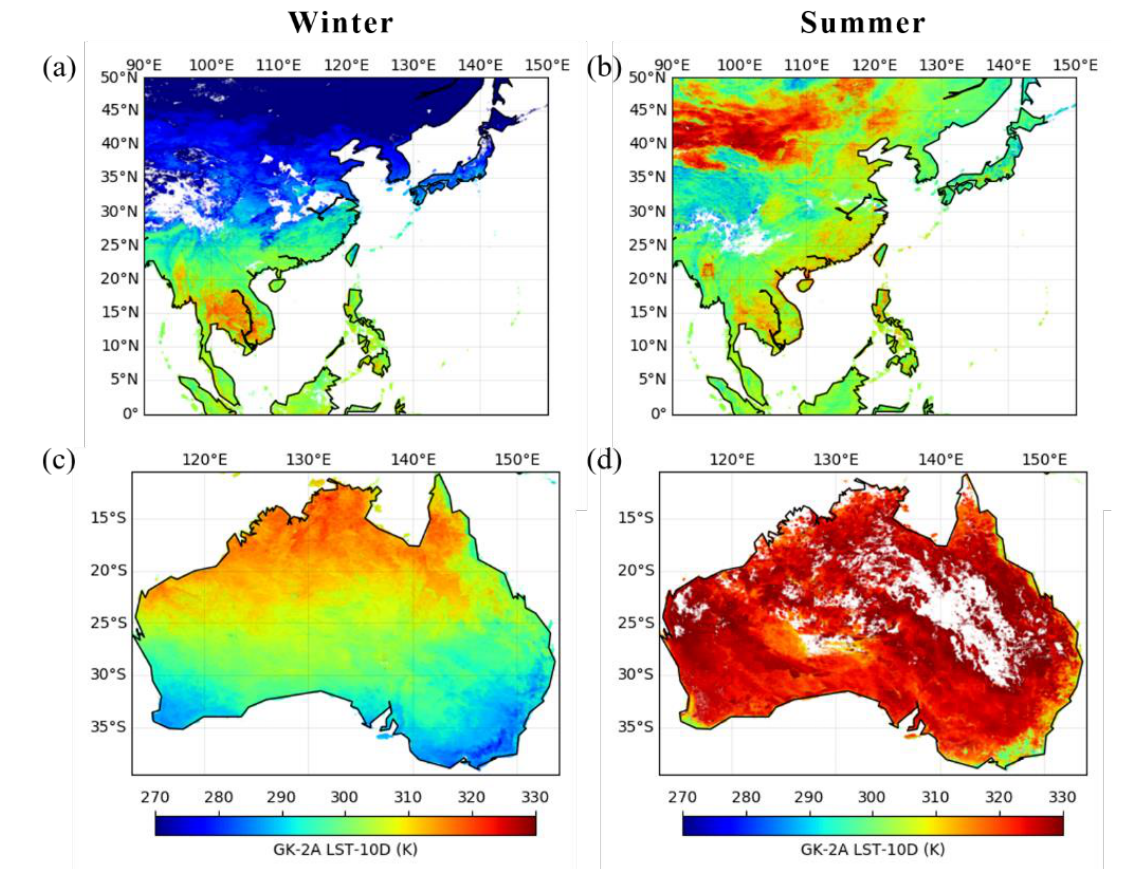
Figure 8. GK-2A LST distributions in East Asia on ( a ) 11 January 2020 (winter) and ( b ) 19 July 2020 (summer) and in